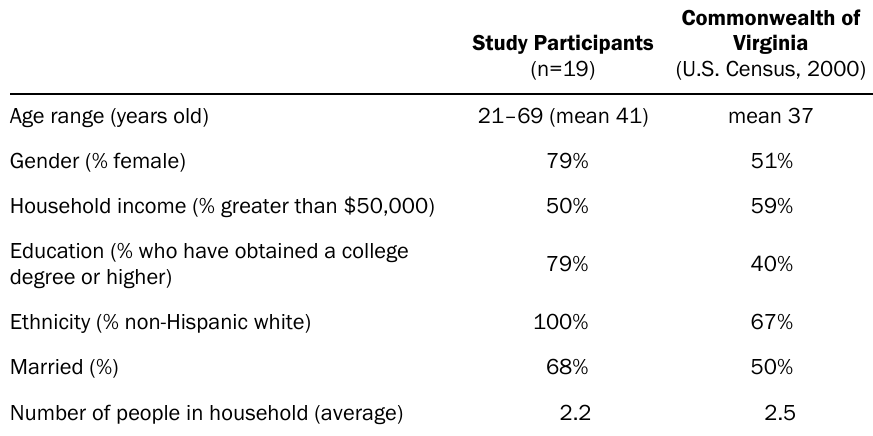
Table 1. Demographic Characteristics of Study Participants and Virginia as a